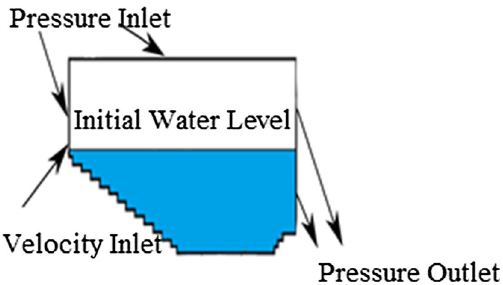
Fig. 3 Boundary conditions of the numerical model of the stilling